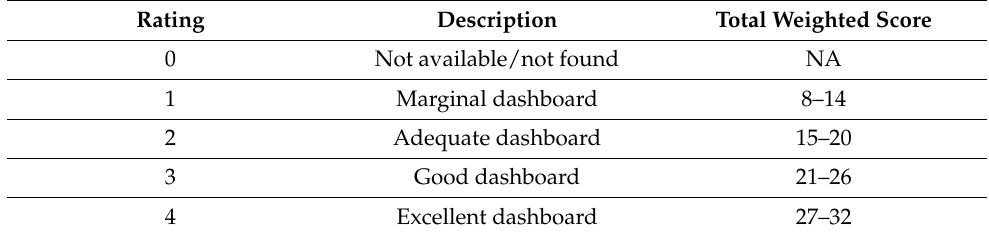
Table 3. Rating matrix for evaluation of